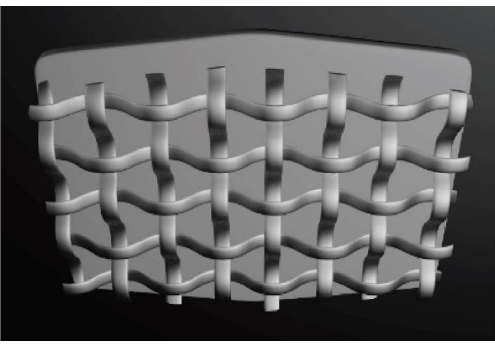
Figure 1: Mesh base